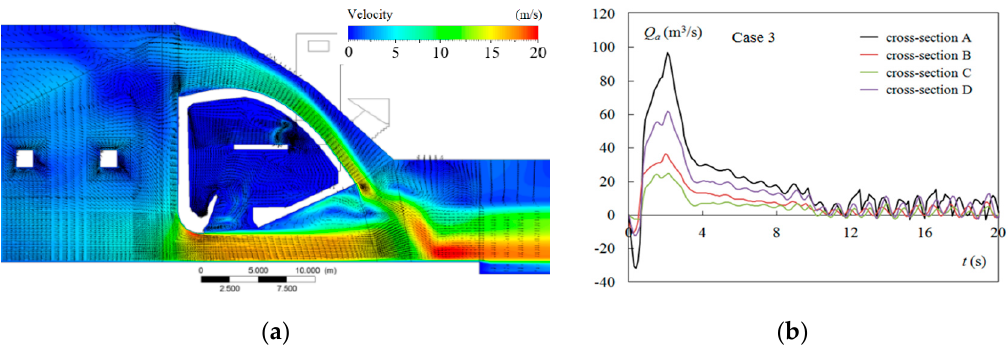
Figure 13. Case 3: ( a ) flow pattern along the right outlet’s centerplane; ( b ) the Q a changes. Table 3. Case 3: time-averaged Q a and V a values at A, B, C and D. Cross-Section